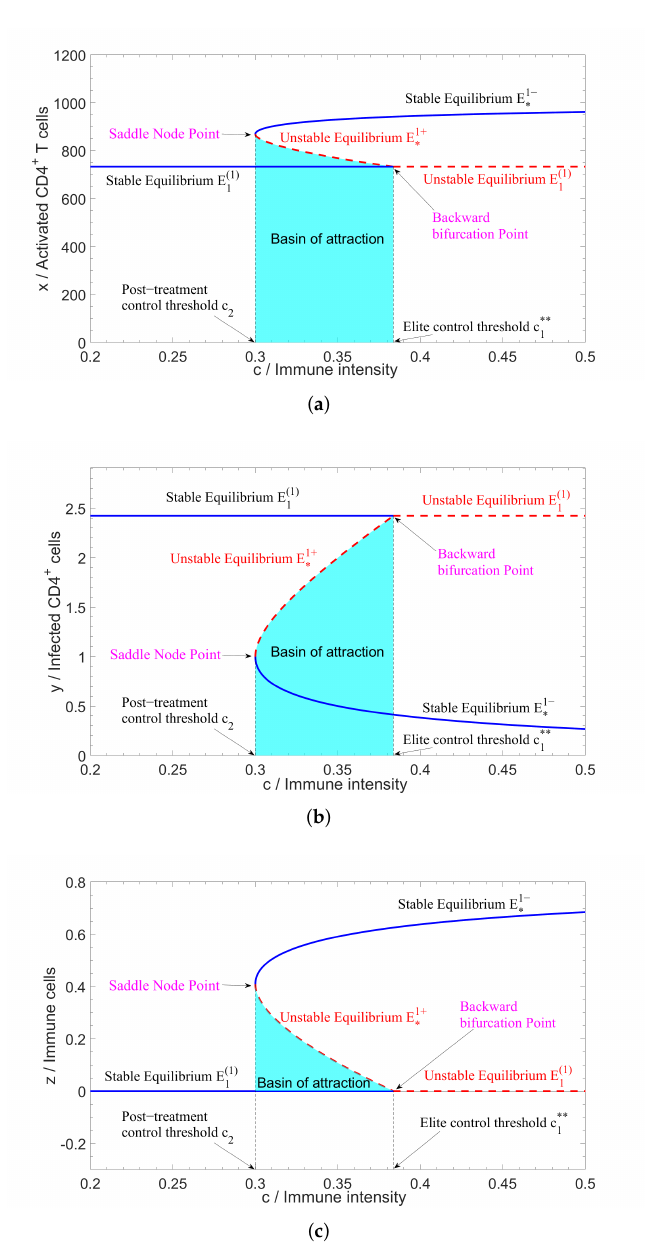
Figure 1. Bifurcation diagrams of system (1) where the vertical axis represents Activated CD4 + T cells (see ( a )), Infected CD4 + T cells (see ( b )) and Immune cells (see ( c )). The parameter values are listed in Table 3. The solid line represents stable equilibria, and the dotted line represents unstable equilibria. The post-treatment control threshold is c 2 ≈ 0.3, the elite control threshold is c ∗∗ ≈ 0.3837, and the bistable interval is ( 0.3,0.3837 )